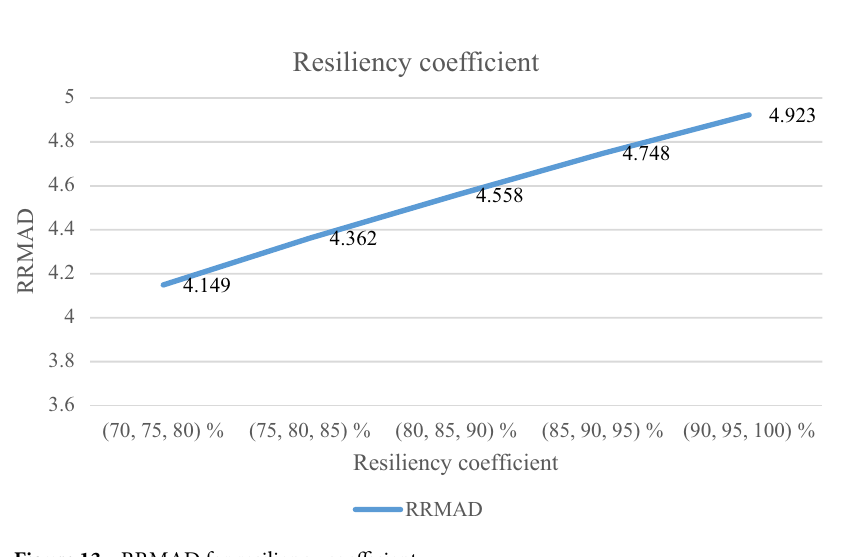
Figure 13. RRMAD for resiliency